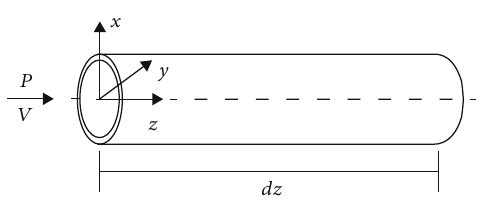
Figure 1: Bionic straight tube microsection force diagram.